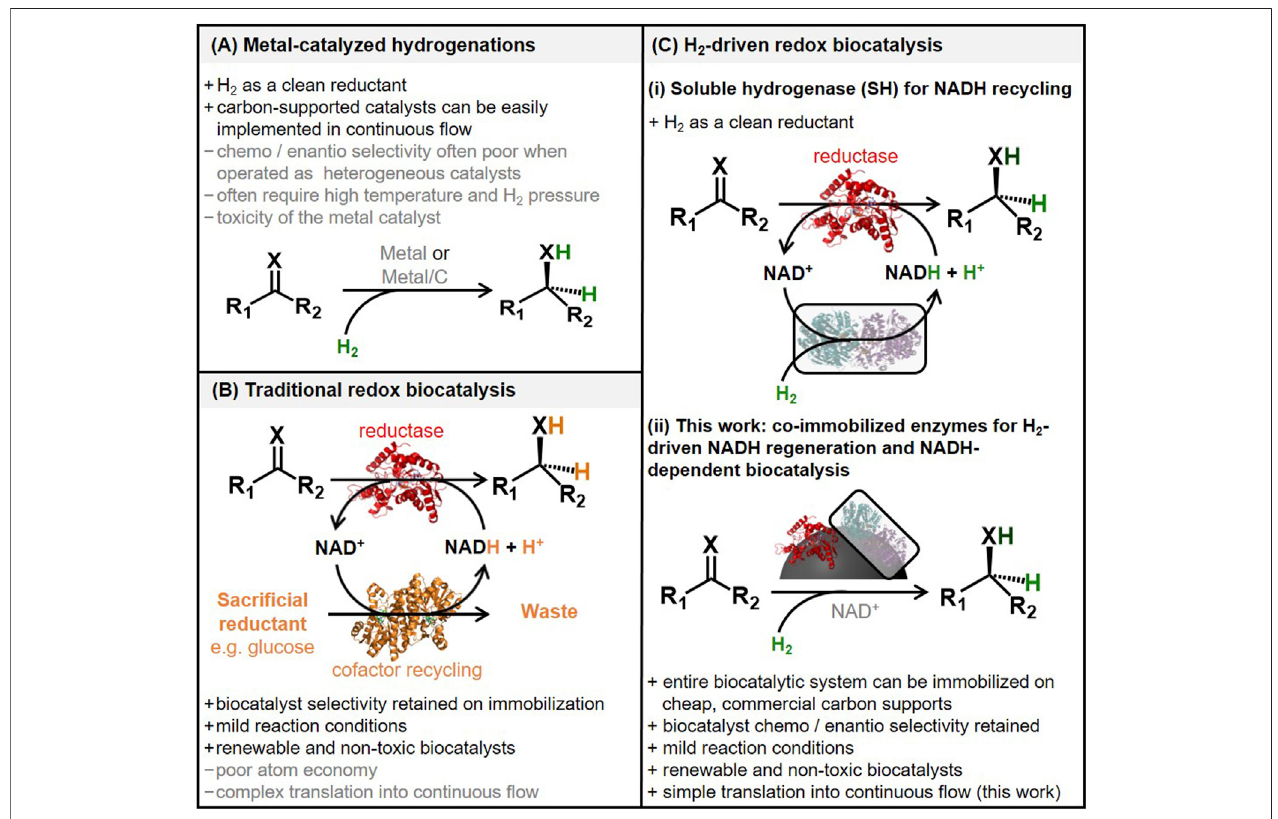
FIGURE 1 | Comparison of asymmetric double bond reduction strategies. (A) Metal-catalyzed hydrogenation. (B) Double bond reduction by a reductase enzyme (red) with NADH recycling by glucose dehydrogenase, alcohol dehydrogenase or formate dehydrogenase (orange). (C) Double bond reduction by a reductase enzyme (red) with H 2 -driven NADH recycling performed [(C), i] in solution or [(C), ii] with enzymes co-immobilized onto carbon (gray). A list of pros (+) and cons ( − ) is shown.